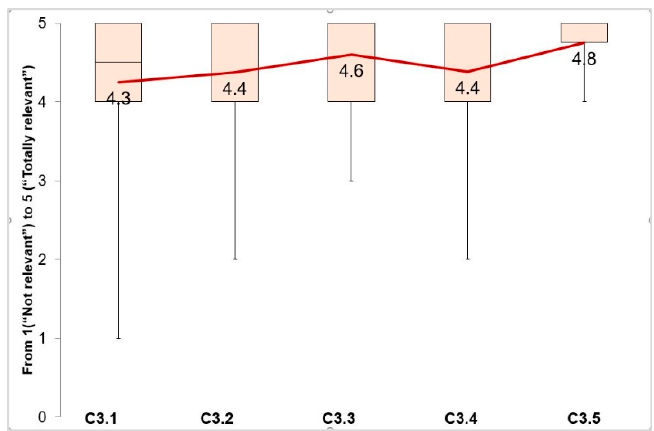
Figure 4. Relevance level (average and range) of information-related factors.